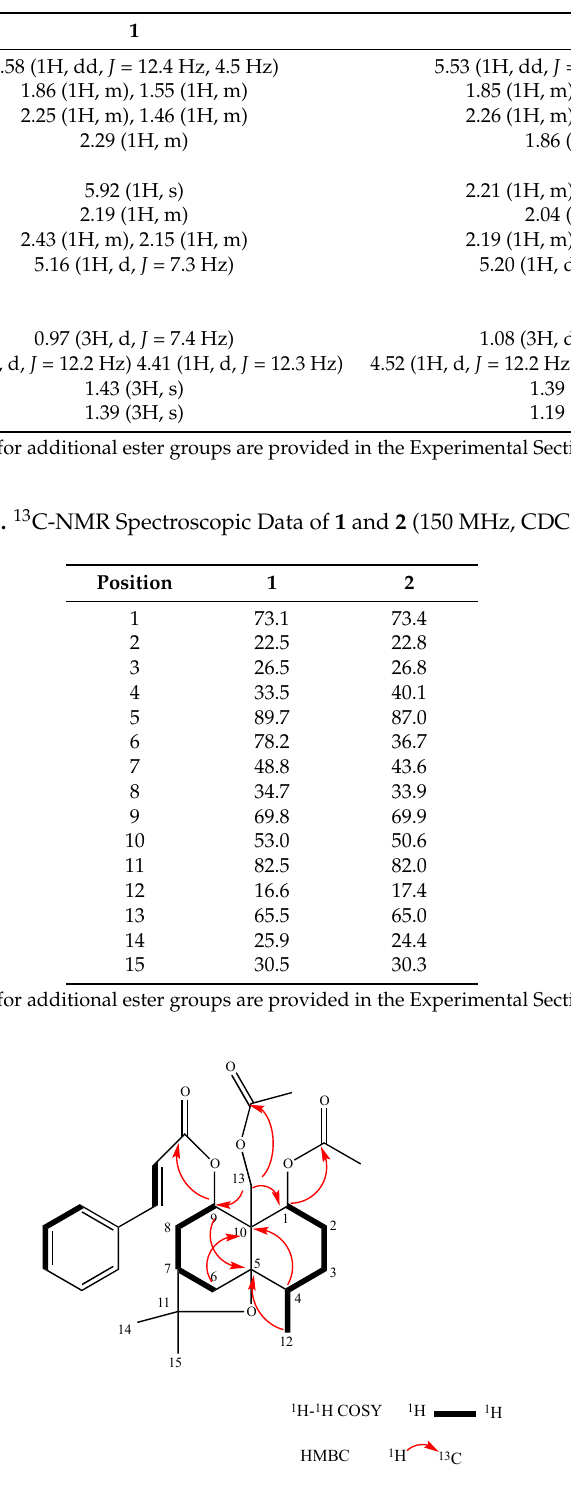
Figure 4. 1 H ‐ 1 H COSY (bold) and selected HMBC (arrows) correlations of Compound 2 . Figure 4. 1 H- 1 H COSY (bold) and selected HMBC (arrows) correlations of Compound 2